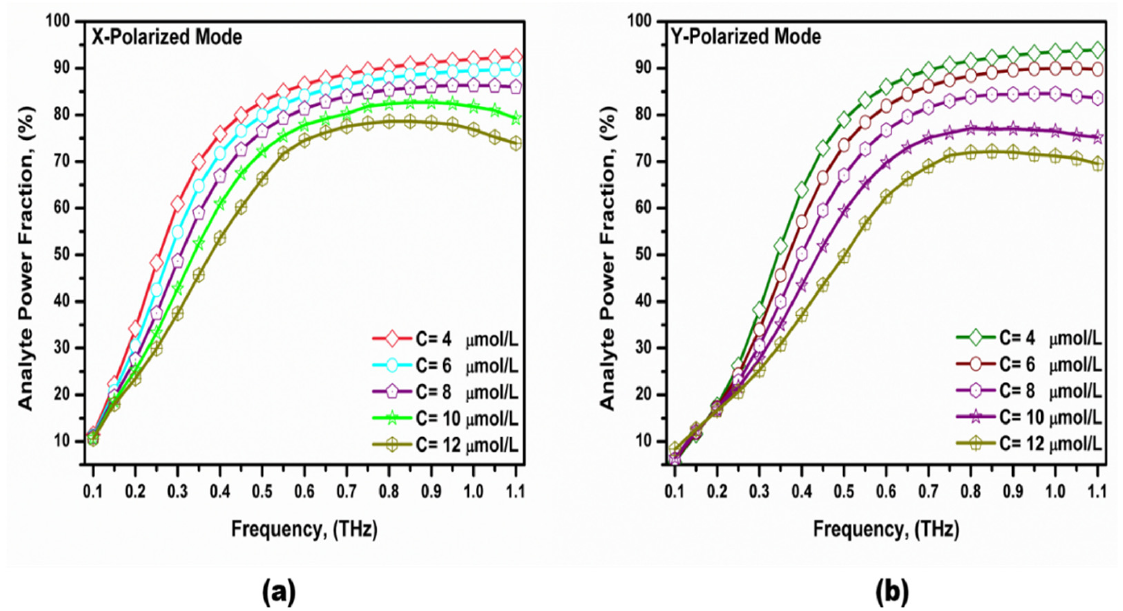
Figure 12. The variation in the analyte power fraction with the frequency for the fundamental ( a ) x-polarized mode and ( b ) y-polarized mode at different bilirubin concentrations for the optimized design.